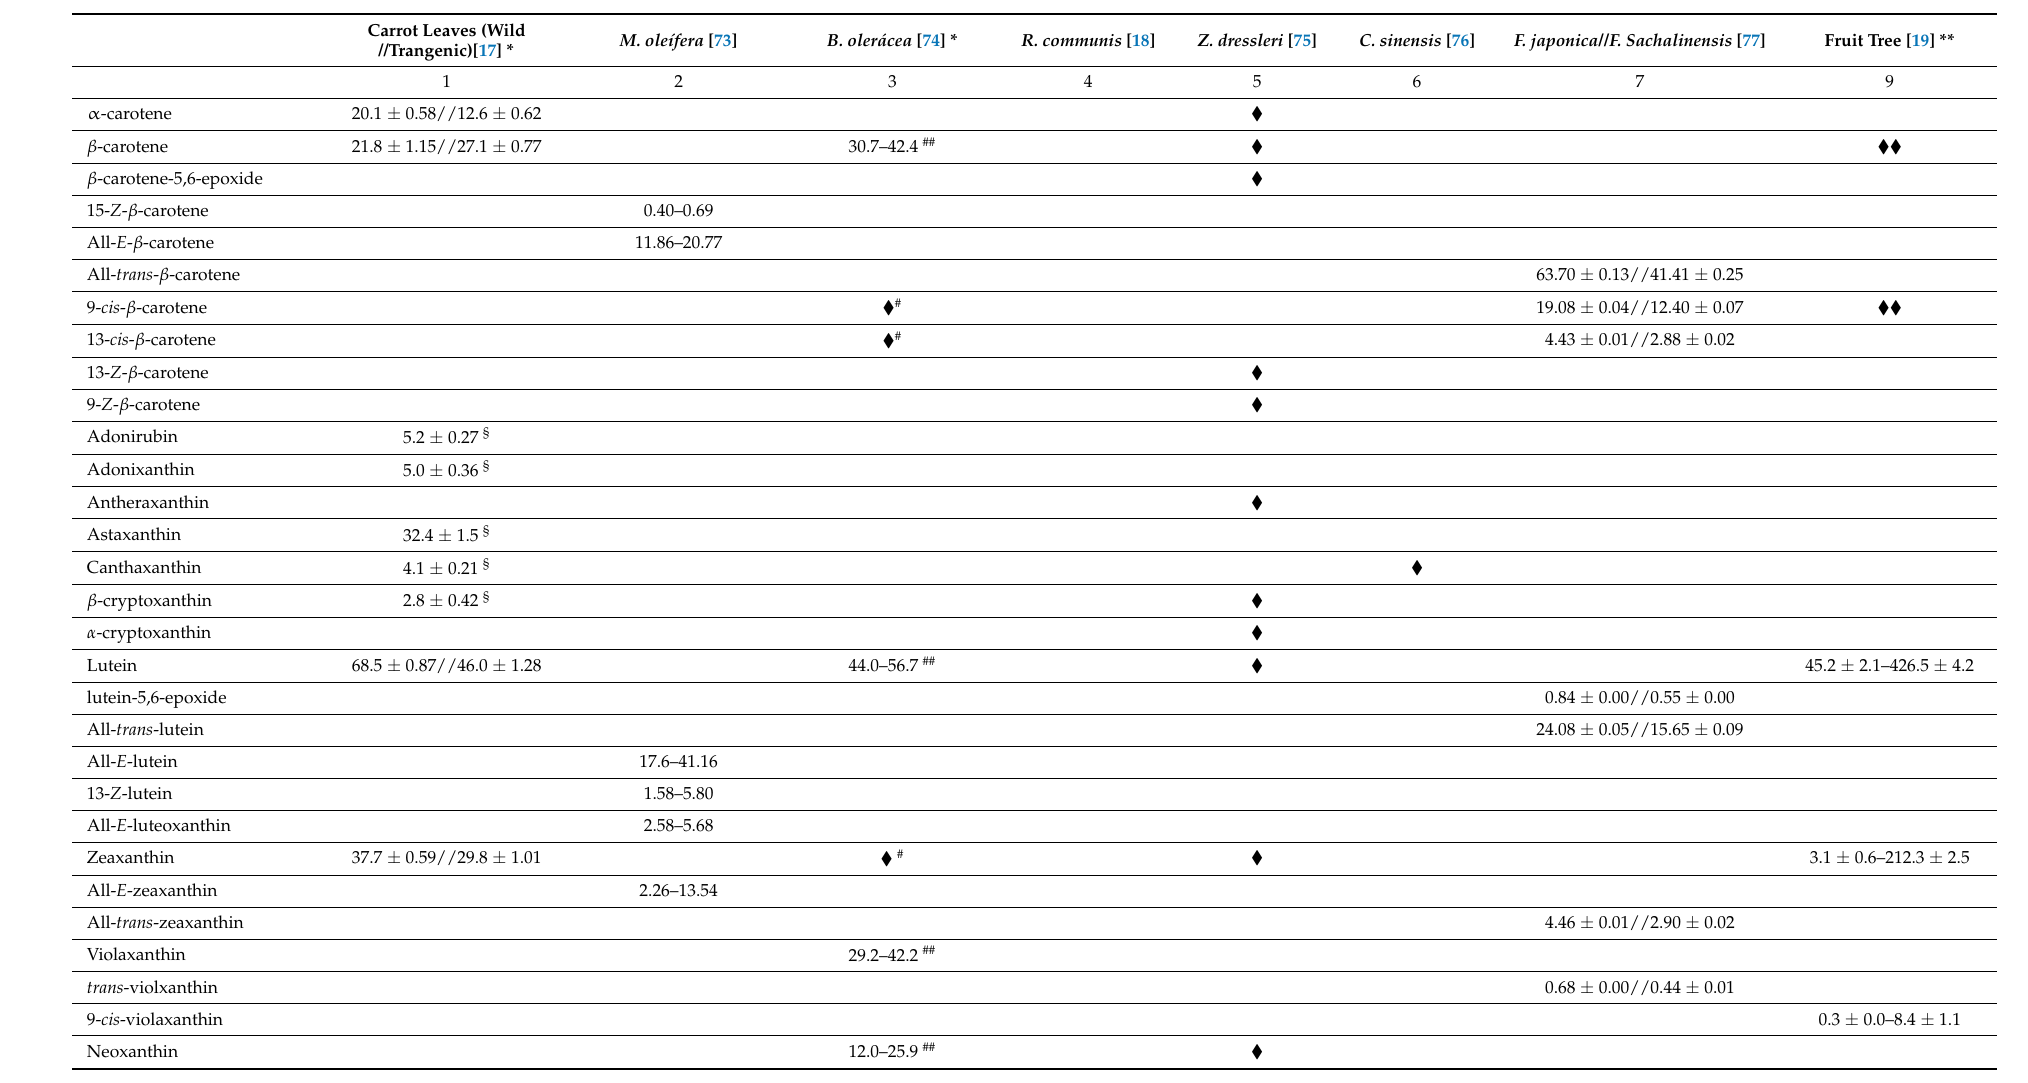
Table 6. Carotenoids and metabolites from the carotenoid pathways identified and quantified in edible plant leaves. Carrot Leaves (Wild //Trangenic)[17]